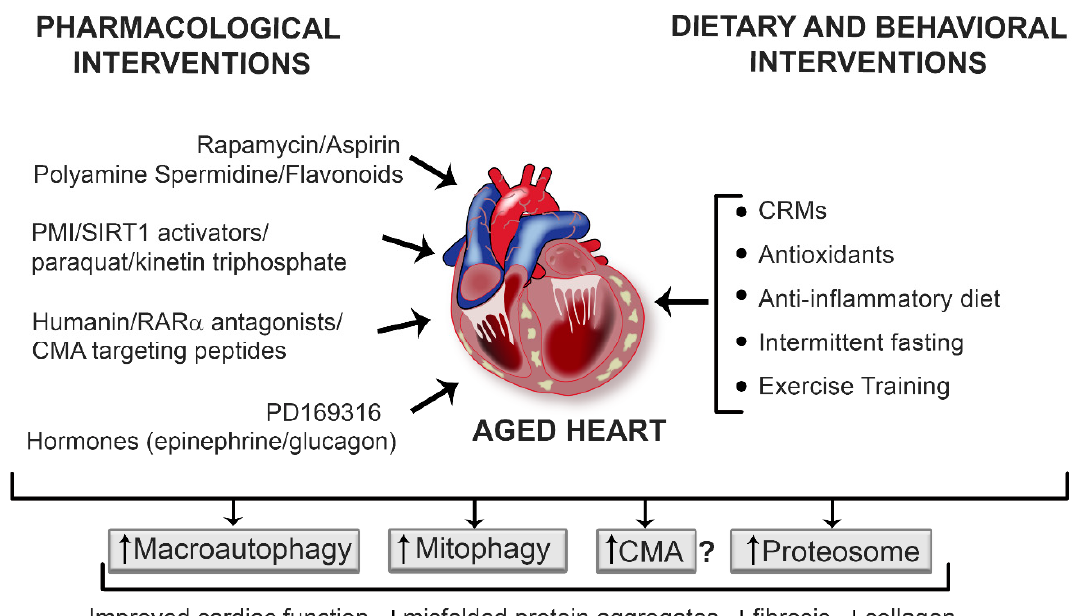
Figure 3. Interventions to upregulate protein quality systems in the aging heart. Nutraceutical (e.g., spermidine), pharmacological (e.g., rapamycin, SIRT1 activators), and dietary and lifestyle (e.g., exercise training, intermittent fasting) approaches have been used to boost protein quality control systems in the heart, in an effort to lessen the severity, delay the onset, or prevent age-associated proteotoxicity and cardiovascular dysfunction. Evidence for the degree of efficacy afforded by each procedure is described in the text. Upregulating the protein quality control mechanisms can prove to be beneficial against various age-related cardiac pathologies. mTOR: mammalian target of rapamycin; PMI: p62-mediated mitophagy inducer; SIRT1: silent mating type information regulation 2 homolog; RAR α : retinoic acid receptor alpha; PD169316: p38 MAPK inhibitor; CRMs: caloric restriction mimetics.